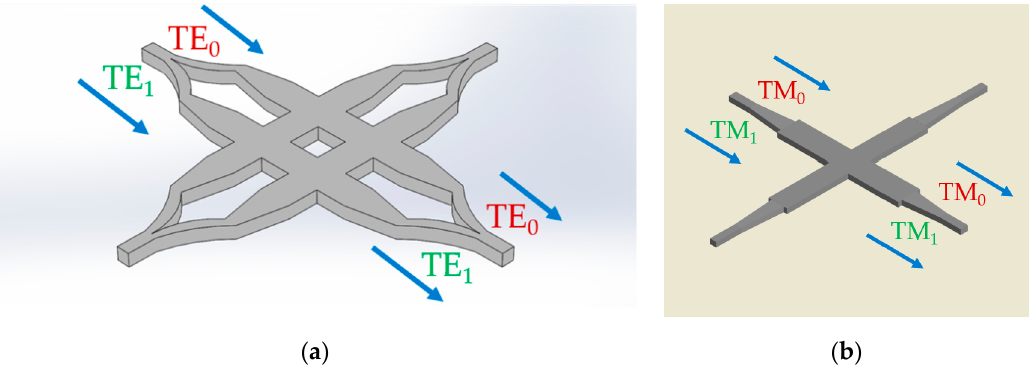
Figure 7. ( a ) Schematic of the mode-multiplexed silicon waveguide crossing with Y-junction mode splitter for fundamental transverse-electric (TE 0 ) and first-order transverse-electric (TE 1 ) mode; ( b ) top view of the mode-multiplexed silicon waveguide crossing with multimode interference structure for fundamental transverse-magnetic (TM 0 ) and first-order transverse-magnetic (TM 1 ) mode.